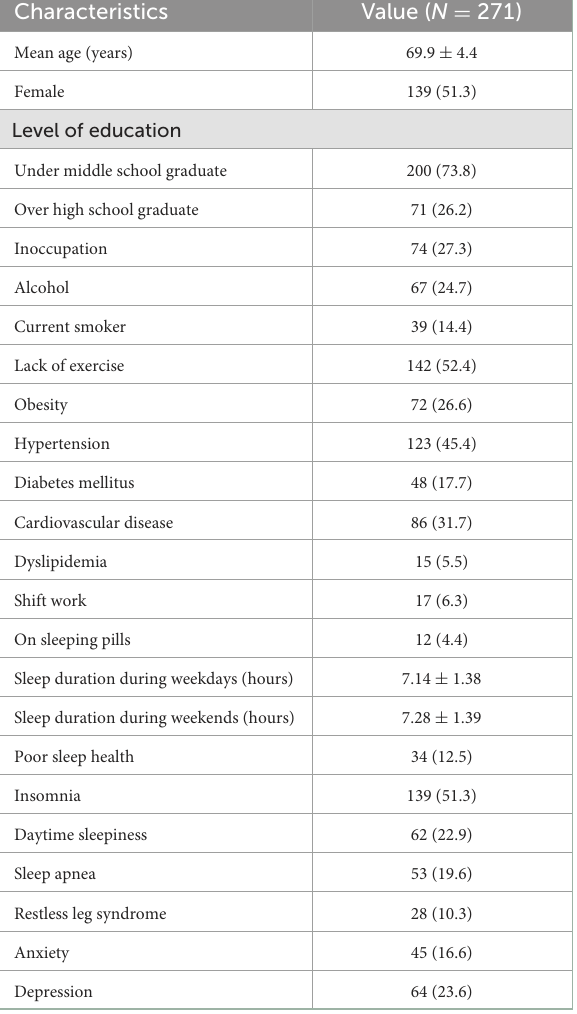
TABLE 1 Sociodemographic characteristics of the study population.